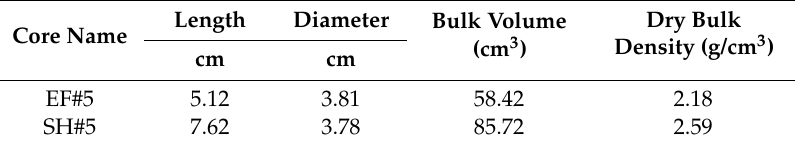
Table 1. Core samples dimensions, bulk volume and dry bulk